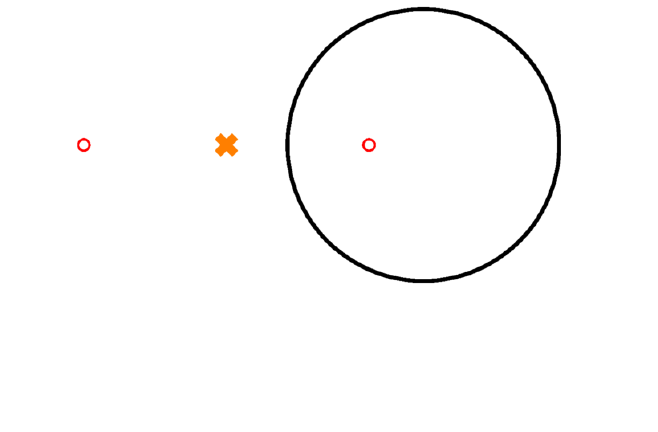
Figure 12. D0-brane around a